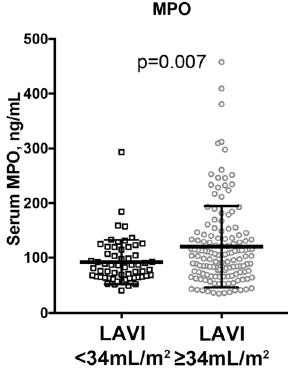
Figure 3. Serum levels of myeloperoxidase (MPO) in patients with and without an enlarged left atrium (LAVI ≥ and < 34 mL/m 2 ). Serum MPO levels were measured by ELISA. Each open square/circle represents one participant. The horizontal lines indicate average ± standard deviation,